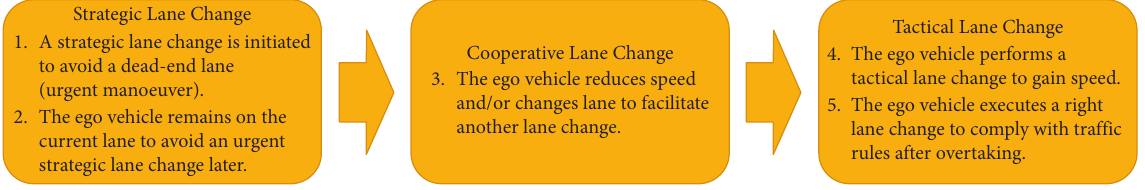
Figure 3: Hierarchy of lane change logic. Table 2: The regression coefficient K e i,j in equation (9).